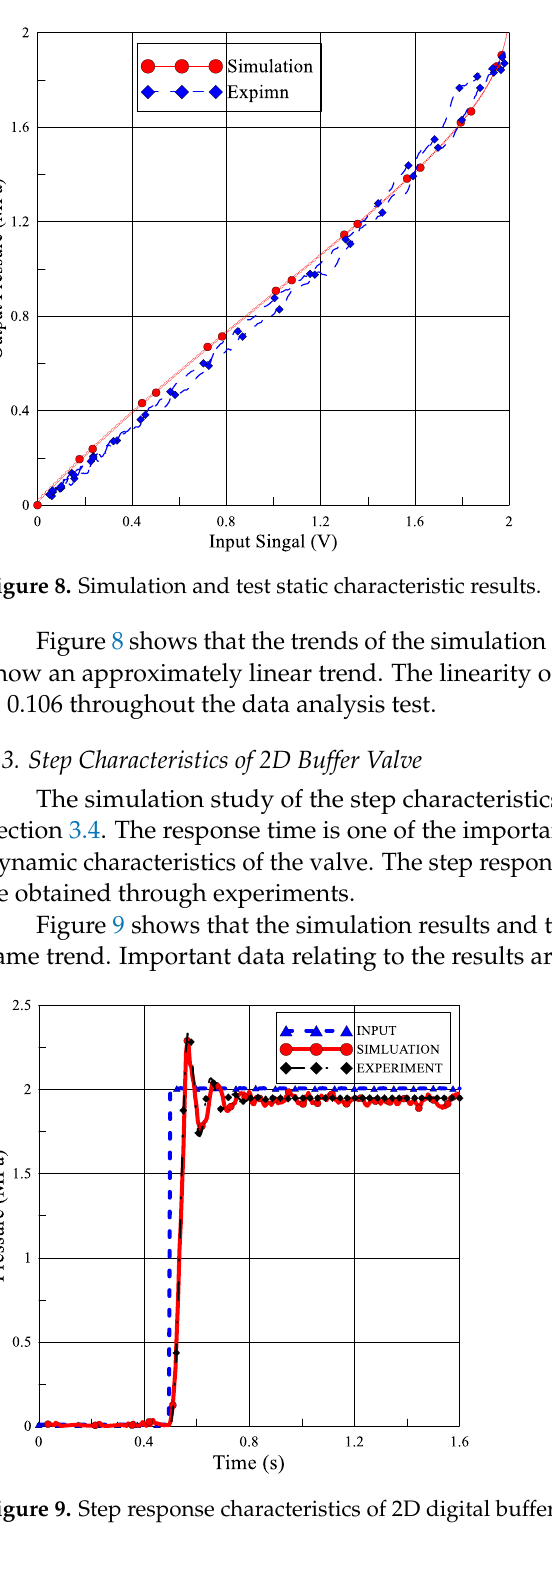
Table 2. Important data relating to results.